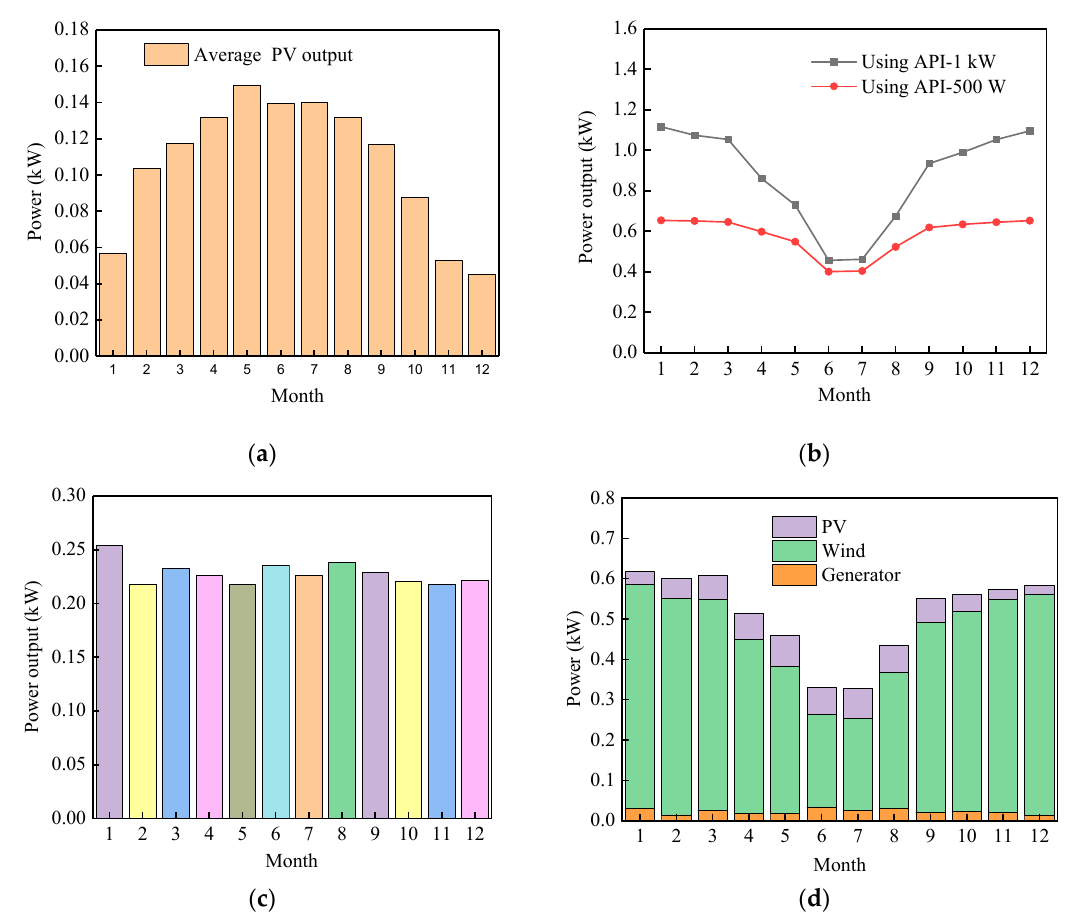
Figure 6. Simulated electricity output on a monthly basis: ( a ) photovoltaic (PV) only, ( b ) wind only, ( c ) biogas generator only and ( d ) average electricity production.